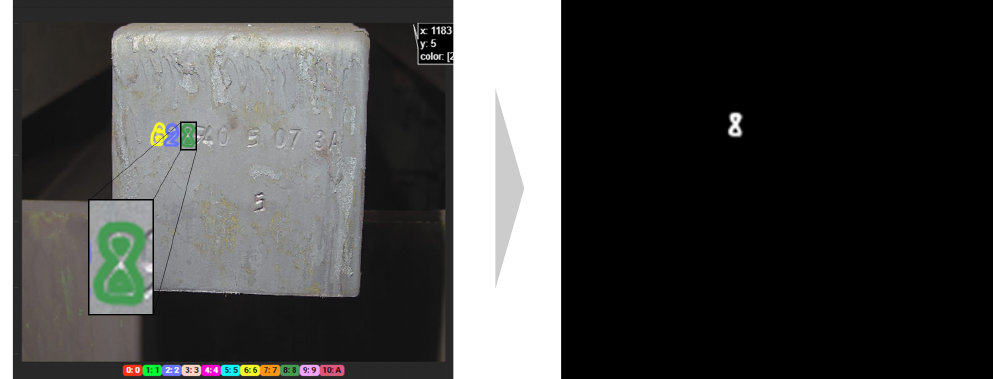
Figure 1. Conversion of a polygonal shape into segmentation mask ( left : polygon of digit 8, right : mask of digit 8 as binary